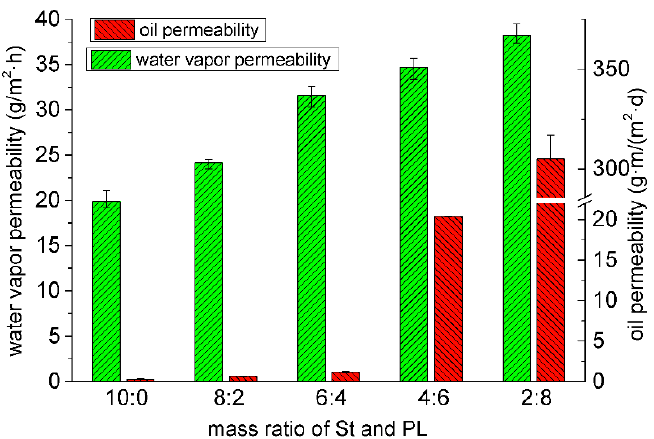
Figure 4. Water vapor permeability and oil permeability of the composite films with St/PL mass ratios.